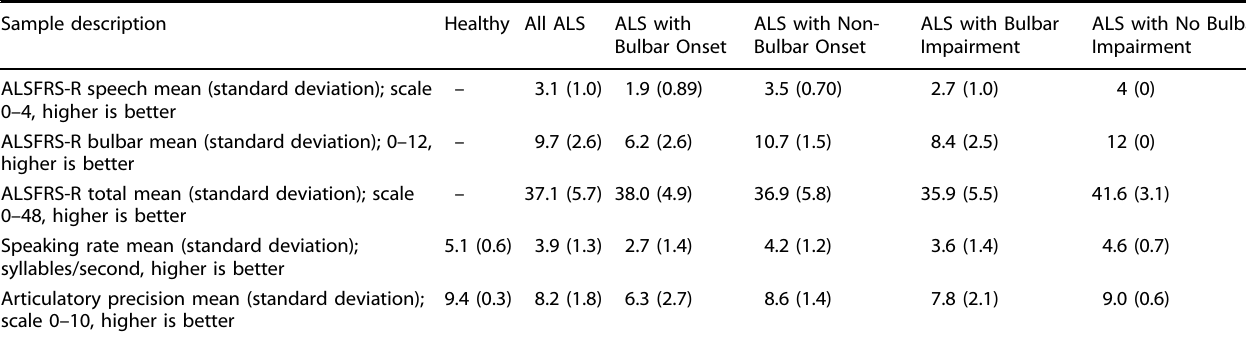
Table 2. Sample Description (by